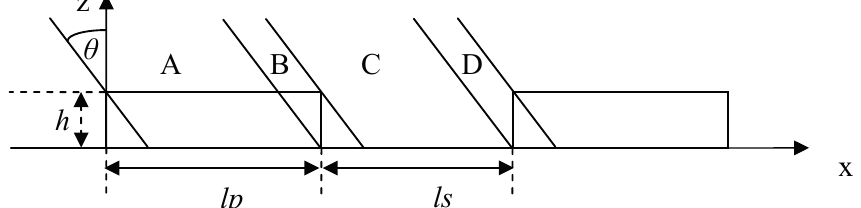
Figure 2. The sketch map of average gap probability calculation.